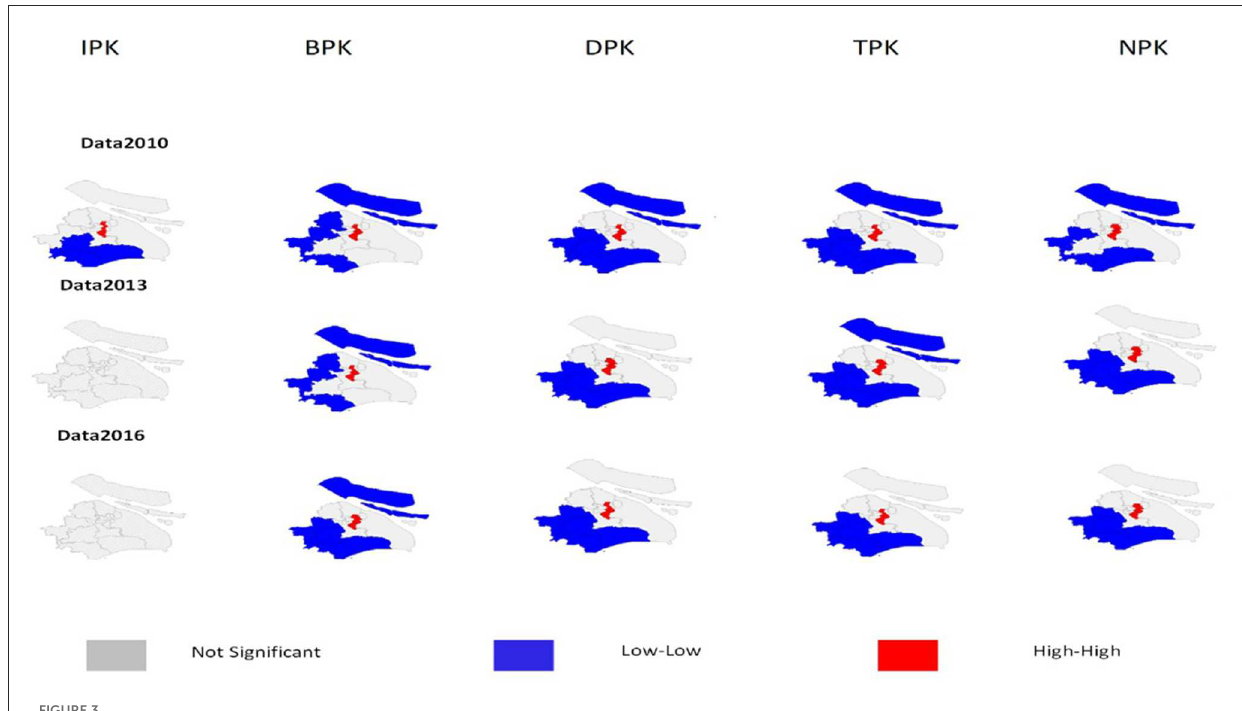
FIGURE3 The cluster map of local Moran’s I analysis from 2010 to